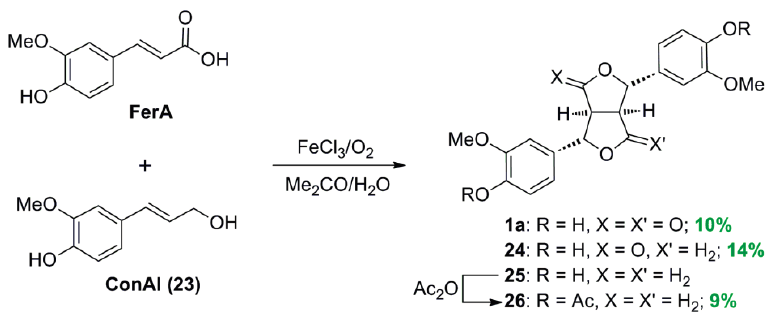
Scheme 17. Cross POC between FerA and ConAl ( 23